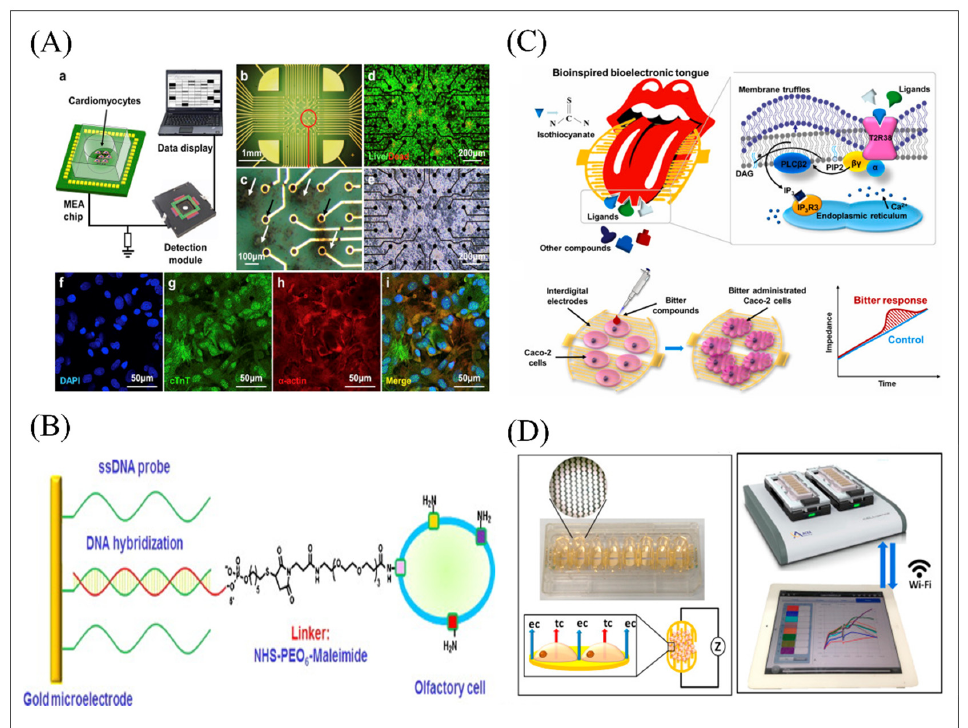
Figure 6. ( A ) The schematic diagram of MEA detection system coated with cardiomyocytes for tastants detection and related optical characterization (b–i). Reproduced with permission from Ref. [82]. ( B ) The schematic of MEA detection system functionalized with olfactory cells through Au-s connection formation and complementary ssDNA hybridization. Reproduced with permission from Ref. [106]. ( C ) Schematic diagram of the activation procedure of gustatory signal pathway and the detection principle of ECIS functionalized with Caco-2 cells expressing T2R38 for bitter compounds detection. Reproduced with permission from Ref. [107]. ( D ) Description of the ECIS recording system functionalized with male mouse germ cells expressing receptor T2Rs for bitter compounds detection and equipped with the iPad controls the recording and setting through Wi-Fi signal. Reproduced with permission from Ref.